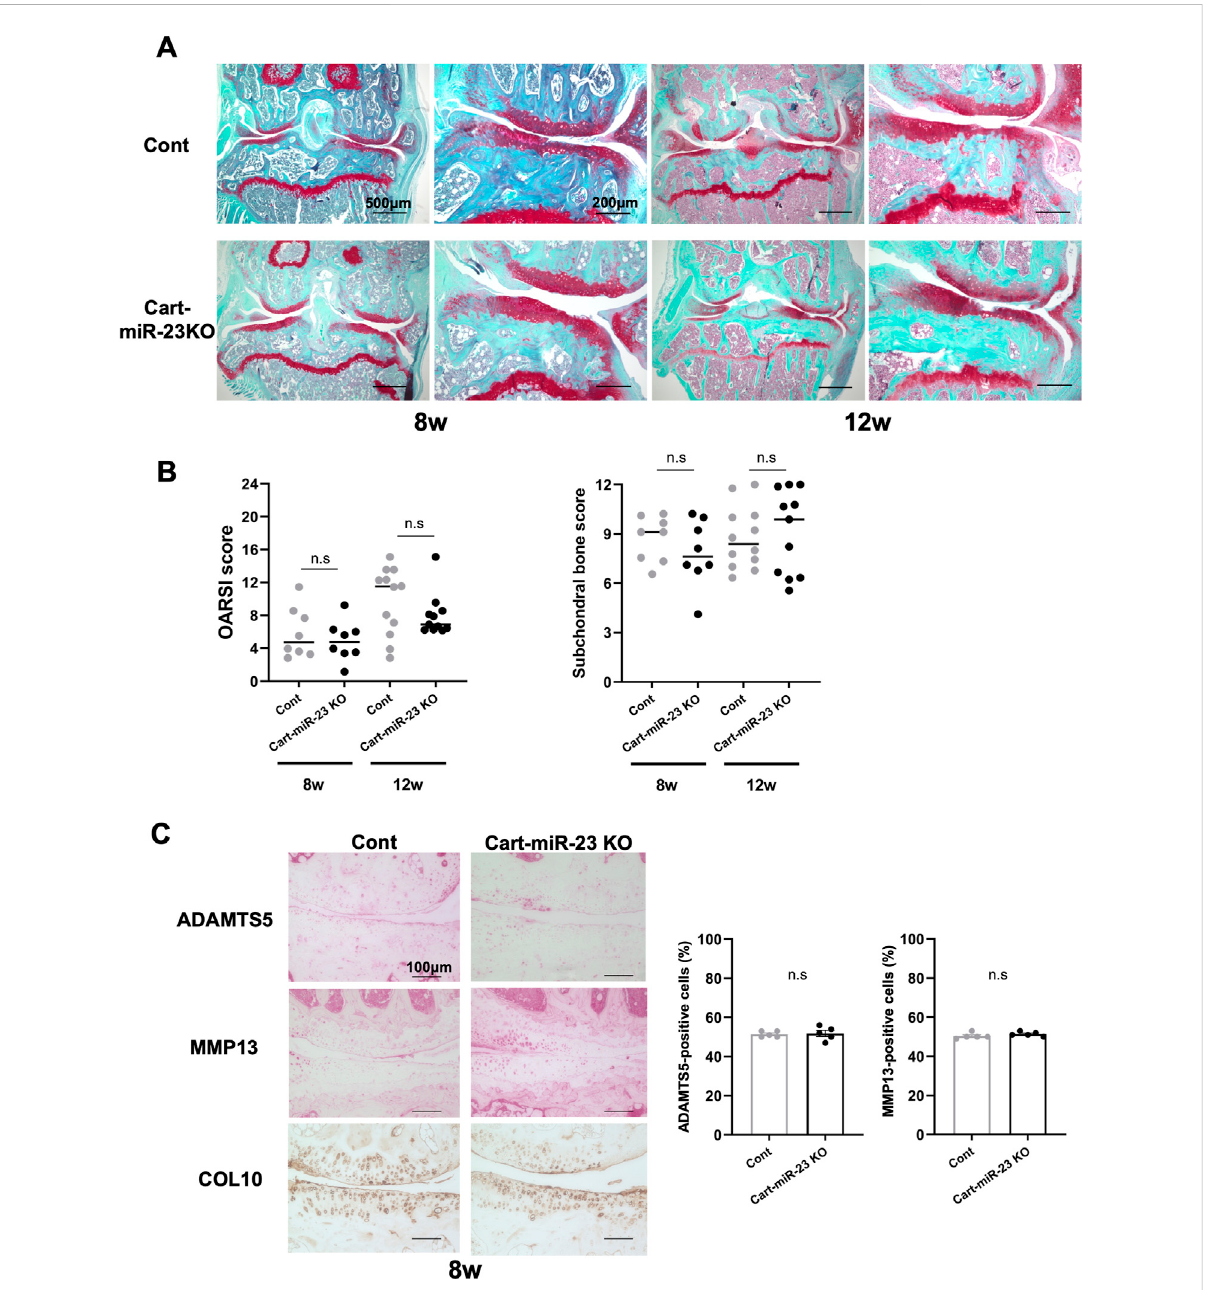
FIGURE 4 Histopathological evaluation of Knee joint tissues of Cart-miR-23clus KO mice in surgically induced OA model. (A) Safranin-O staining in the knee joints of Control and Cart-miR-23clus KO mice in surgically induced OA model. Scale bars: 500 µm and 200 µm. (B) The right knee joints of ControlandCart-miR-23clusKOmiceafter8 weeks(Control: n =8,Cart-miR-23clusKO: n =8)and12 weeks(Control: n =12,Cart-miR-23clusKO: n = 11) of surgery were assessed by OARSI scoring and ScB scoring system. The data was represented as median. Scoring data was analyzed by Kruskal – Wallis test, then Dunn ’ s multiple comparison test was applied. (C) Knee joints from Control and Cart-miR-23clus KO mice after 8 weeks of surgery were assessed by immunohistochemistry using anti-ADAMTS5, anti-MMP13, and anti-type X Collagen antibodies ( n = 5 per group). Scale bars:100 µm.Thedatarepresentedasmean±SEM.ComparisonofmeanvalueswasperformedusingWelch ’ s t -test.n.s:non-signi fi